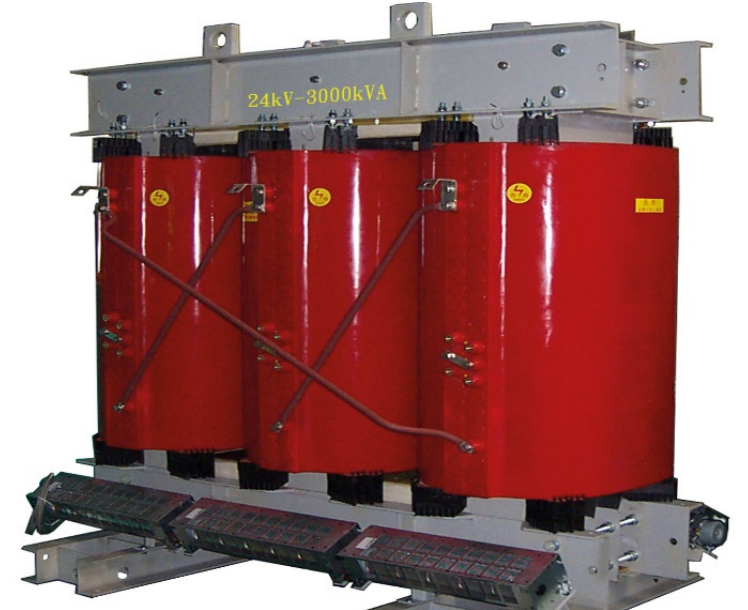
Figure 12. Epoxy-resin cast dry type transformer.